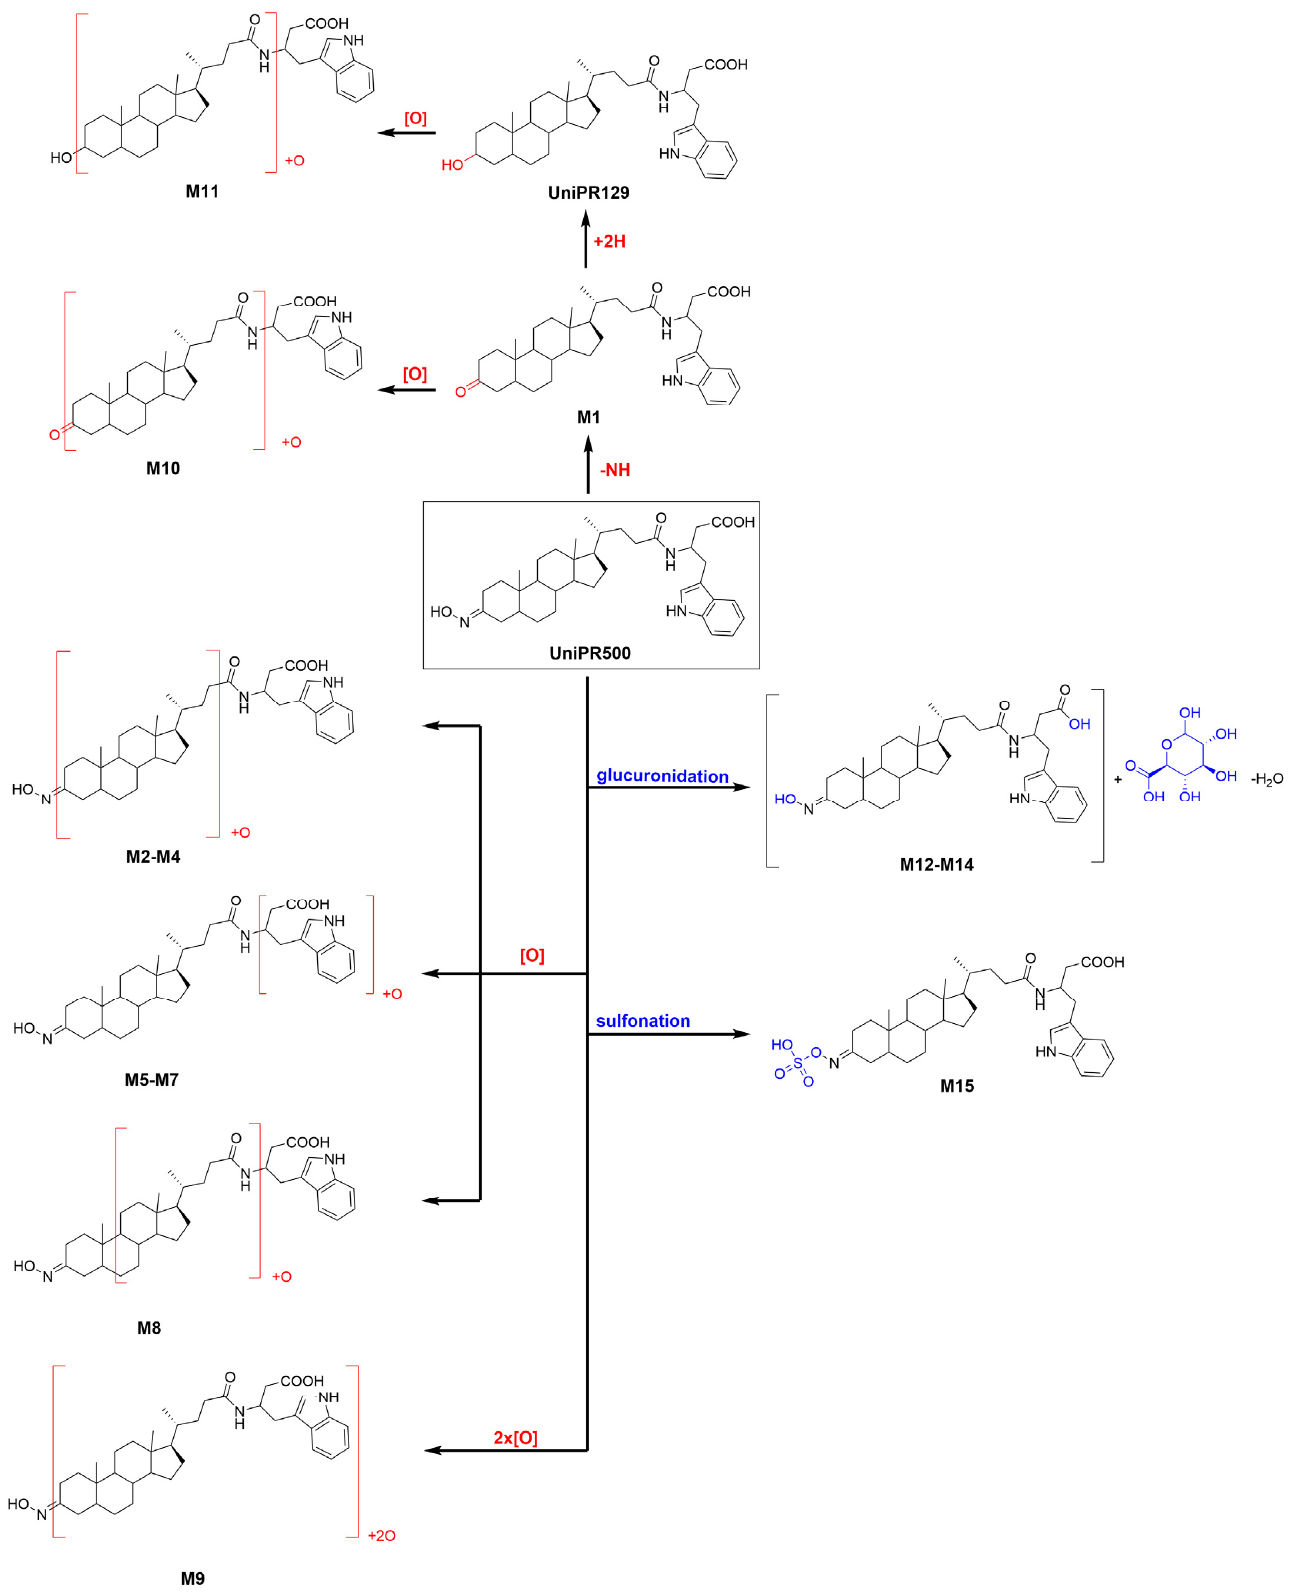
Figure 8. Metabolic tree of Unipr500 plausible phase I and II in vitro biotransformations.